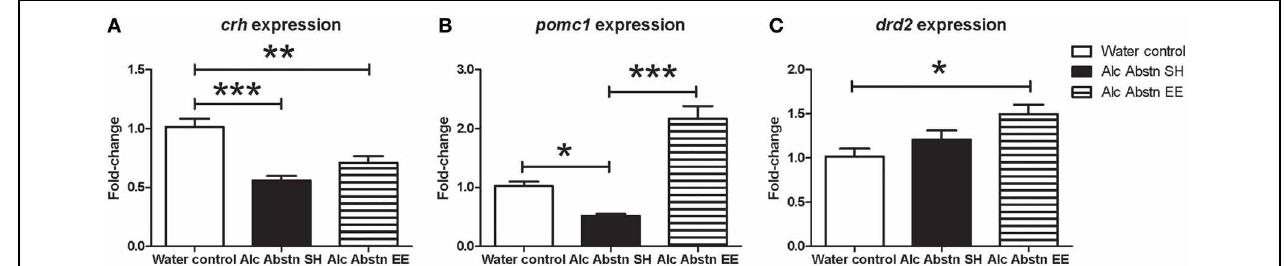
FIGURE 5 | Differential effects of enrichment on hypothalamic and pituitary gene expression. (A) Hypothalamic Crh expression was significantly reduced in the standard-housed Alc abstn group, and unaltered by enrichment. (B) Pituitary pomc1 expression was significantly reduced in the standard-housed Alc Abstn group but was significantly elevated in the enriched group. (C) Pituitary Drd2